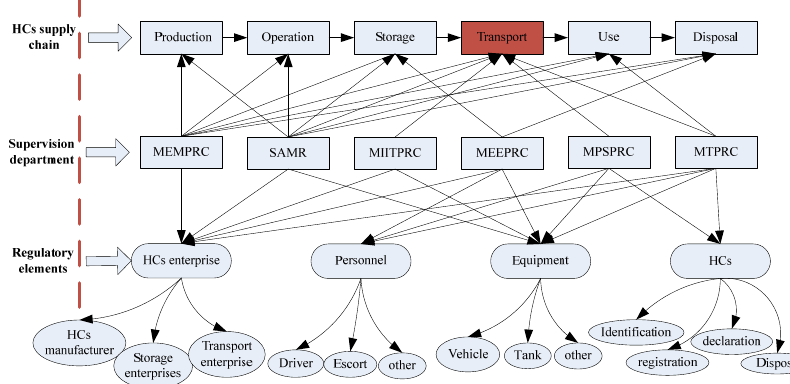
Figure 1. Safety supervision network of HCs.